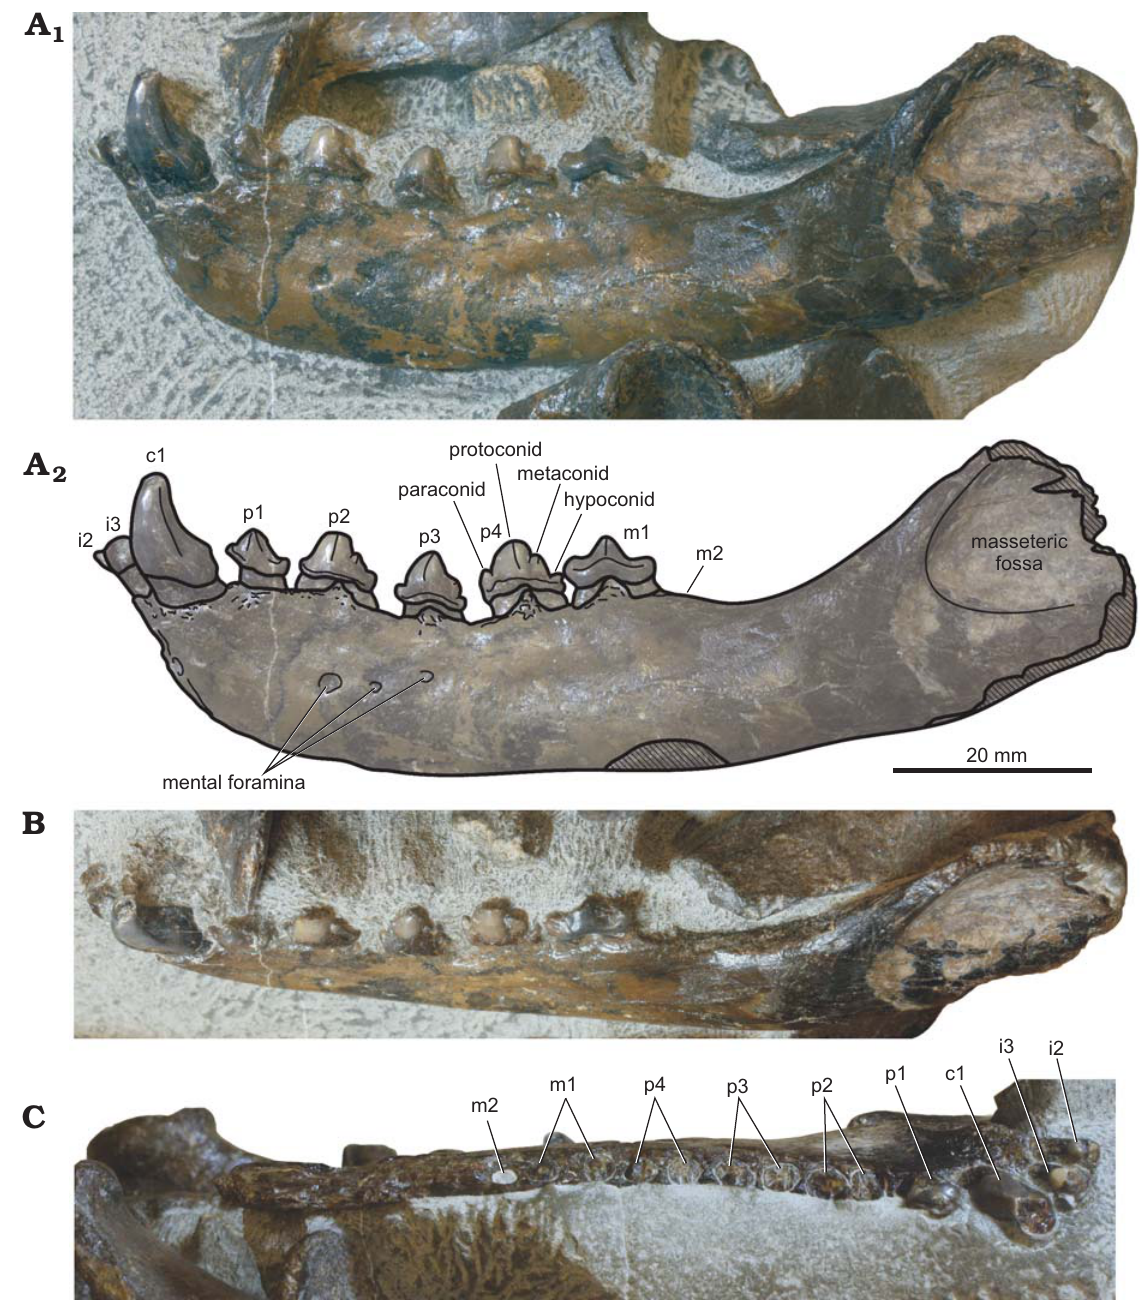
Fig. 7. Mandibles and vertebrae of pinniped mammal Enaliarctos sp. (UWBM 89114) from Moolack Beach, Lincoln County, Oregon, Astoria Formation, late early Miocene. A . Left mandible in labial view; photograph (A 1 ), explanatory drawing (A 2 ). B . Left mandible in occlusal view. C . Right mandible in occlusal